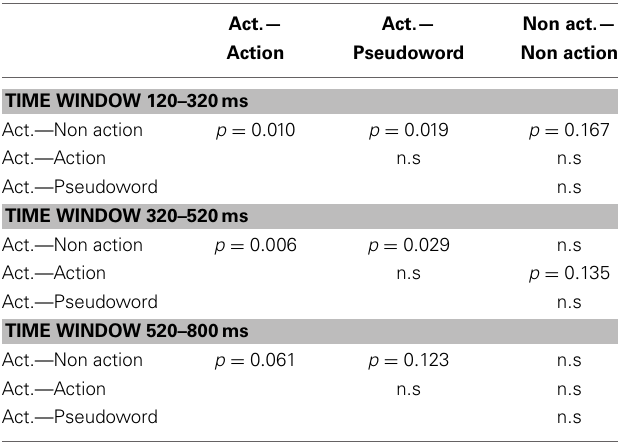
Table 4 | Results of the post-hoc tests (Bonferroni) for the different